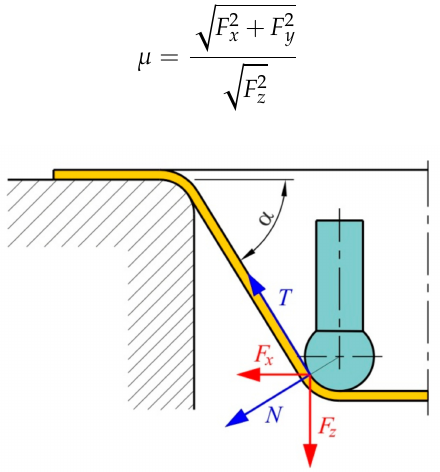
Figure 32. Relationship of the forming force